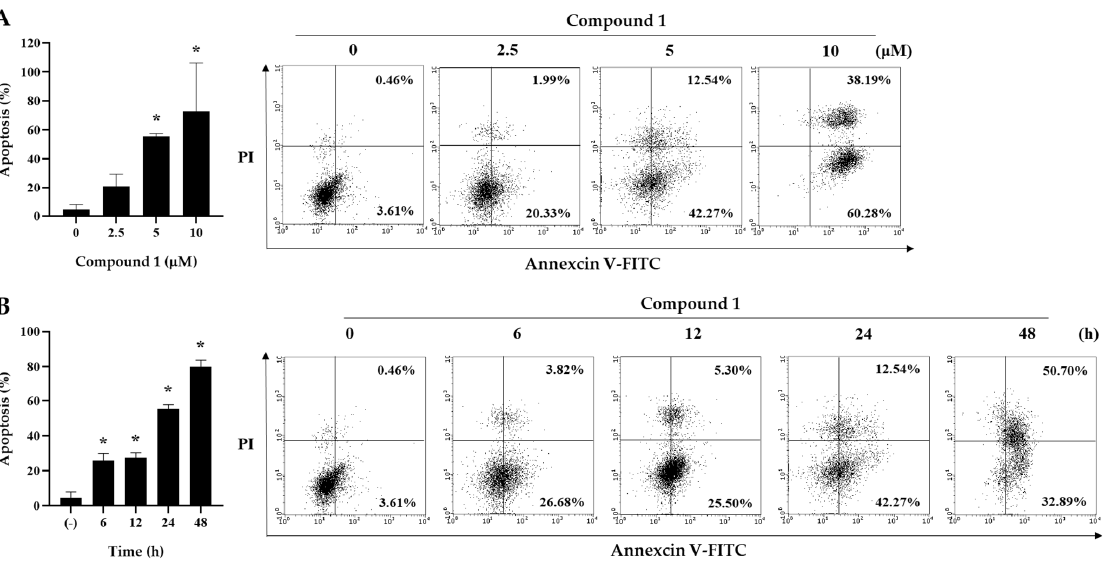
Figure 4. The effect of compound 1 on apoptosis in A2780 cells. Cells were treated with compound 1 for the indicated concentrations (2.5, 5.0, and 10 μ M) ( A ) and times (6, 12, 24, and 48 h) ( B ), and then co-stained with propidium iodide (PI) and Annexin V-FITC. The graph indicates the percentage of apoptosis. Data are presented as mean ± SD and evaluated by one-way ANOVA analysis. * p < 0.05 as compared with control.